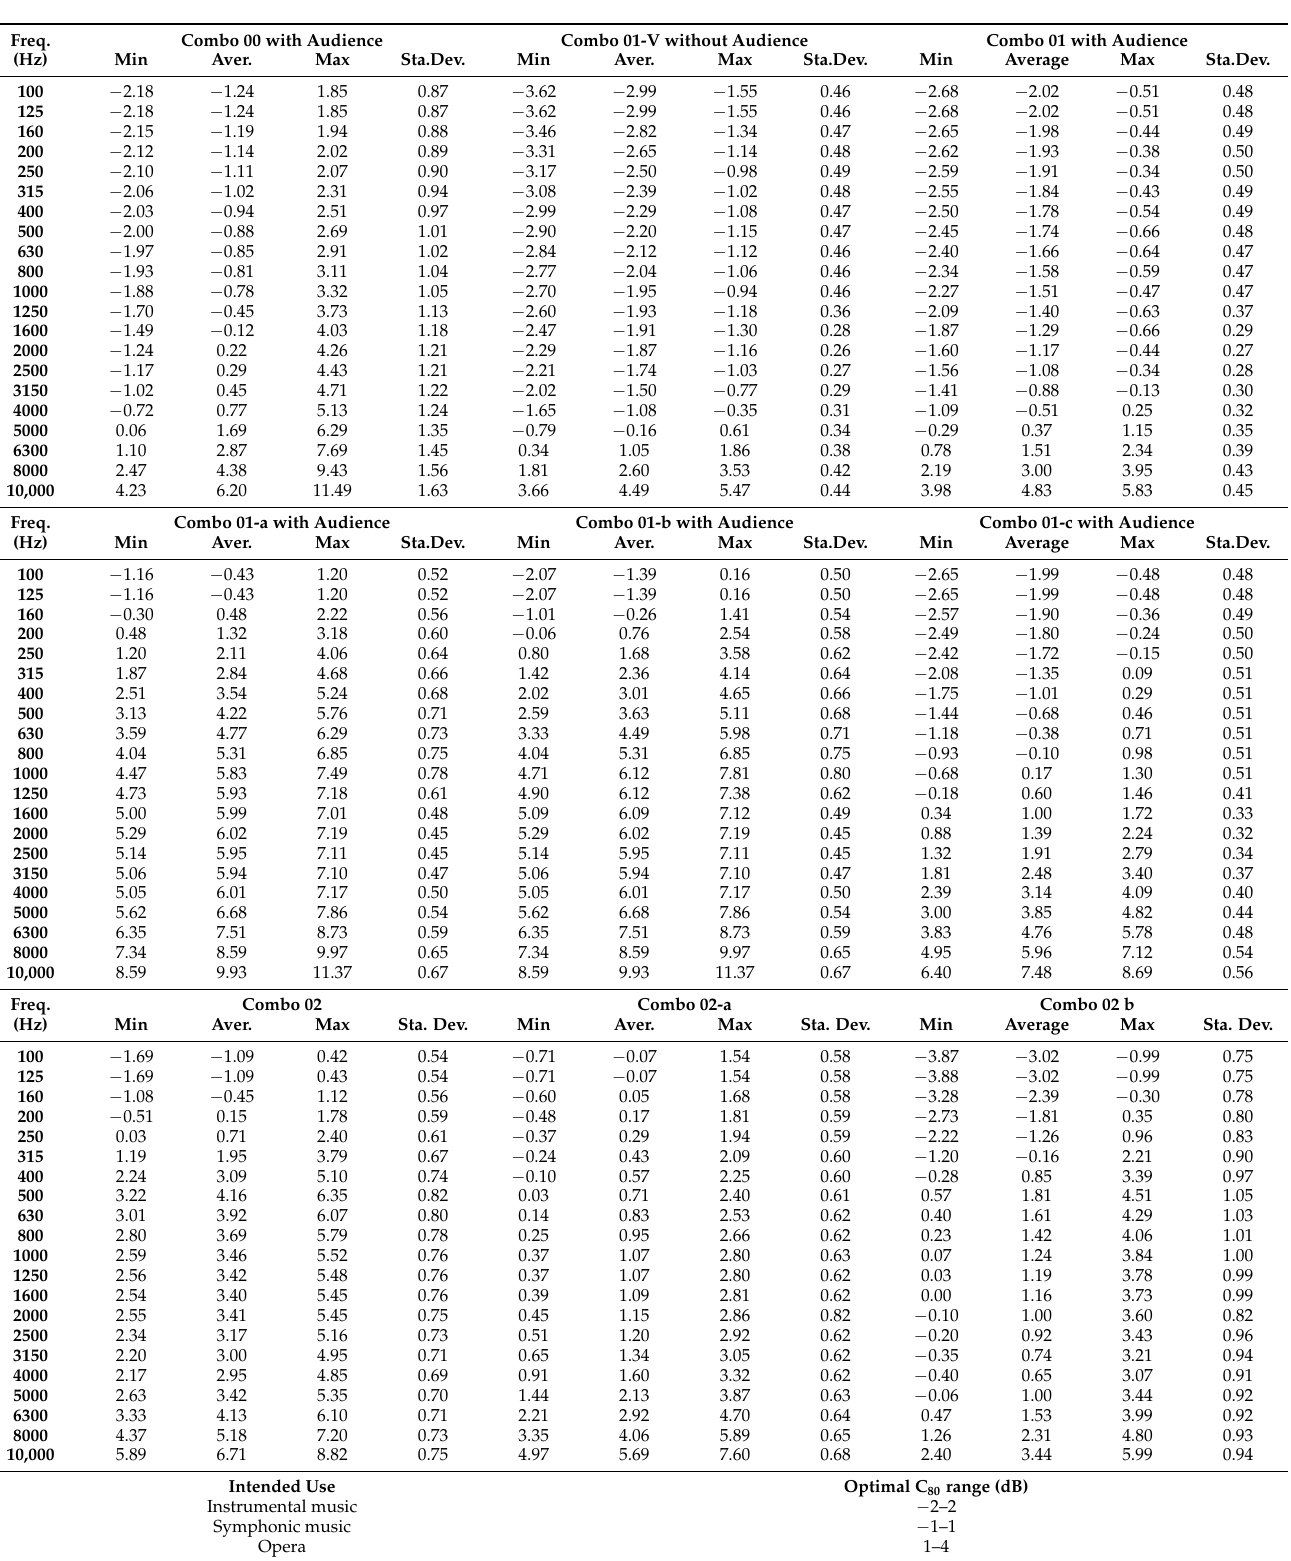
Table 15. Clarity index C 80 according to the intended use of the